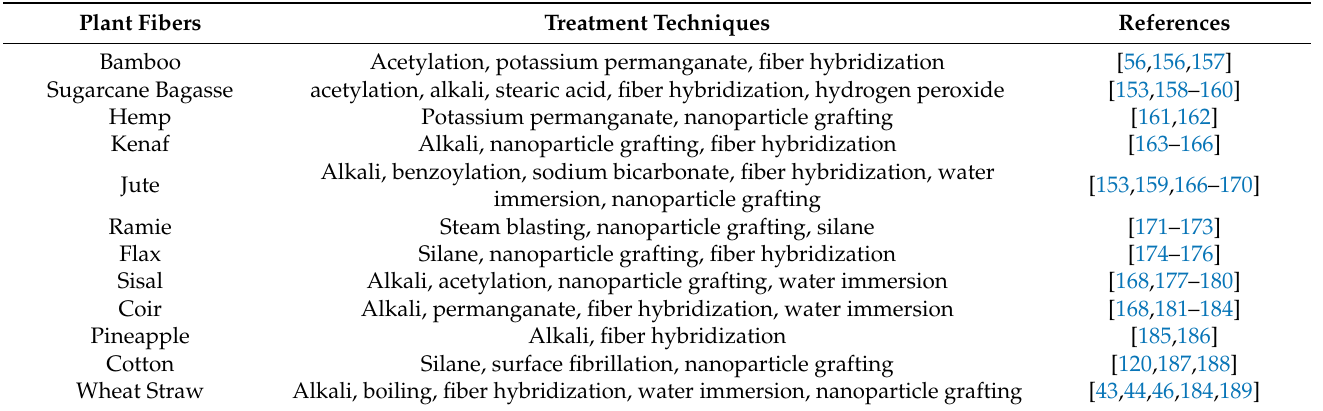
Table 3. Different proposed treatments for plant fibers.